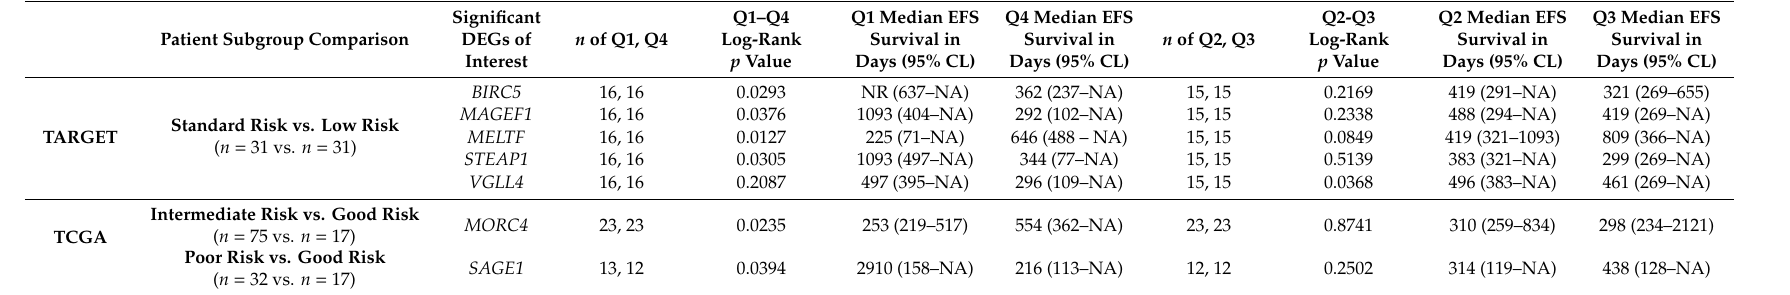
Table 2. Significant log-rank test results for significantly di ff erentially expressed GOI.